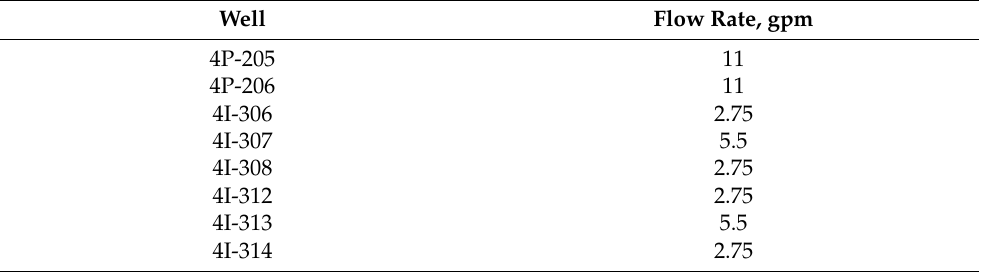
Table A9. Target flow rates during and after the sodium acetate injection (wells not listed had no flow—only two patterns were operated). Well